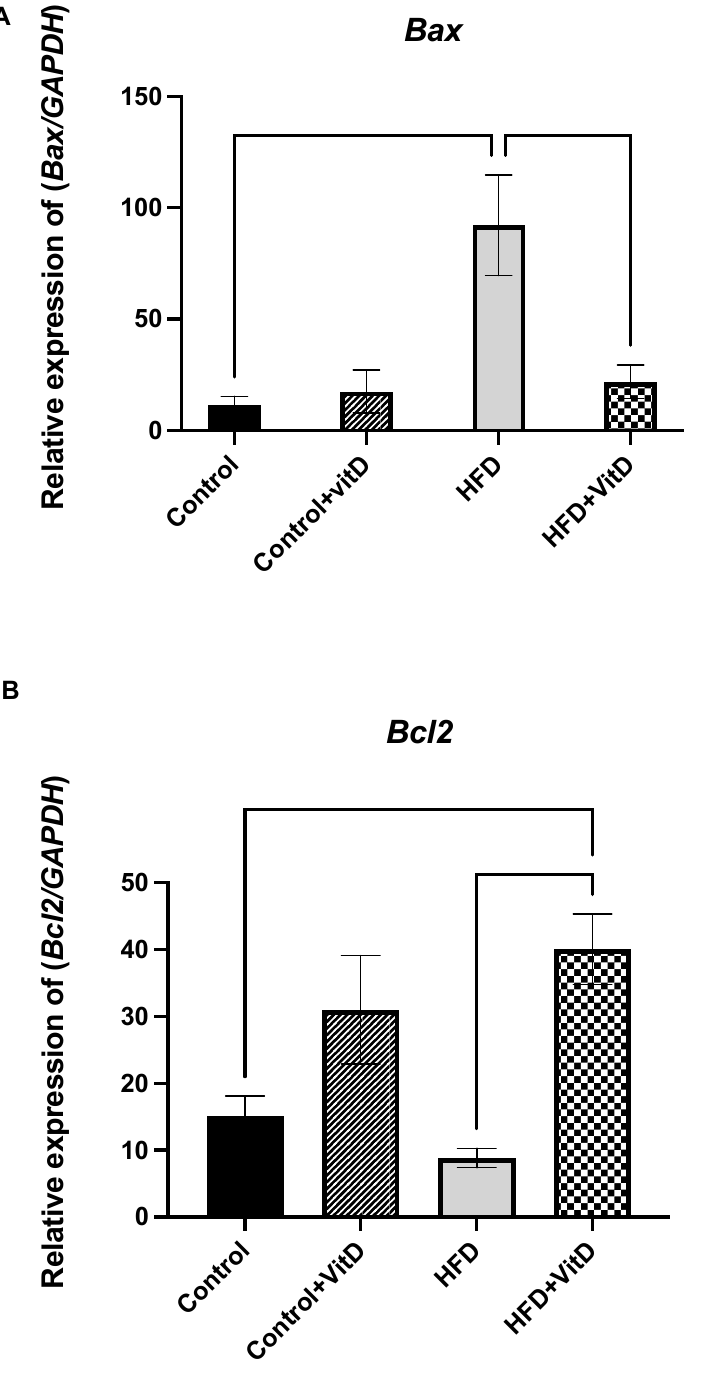
Figure 1. Gene expression of the intrinsic apoptotic signaling genes. ( A ) The gene expression of the pro-apoptotic Bax in rats fed with a normal diet (Control), a high-fat diet (HFD), and a vitamin D-supplemented HFD (HFD + VitD). Bax was significantly increased in the group fed with the HFD ( p = 0.013) relative to the control. Combining vitamin D with the HFD downregulated the expression of this gene ( p = 0.02). ( B ) The gene expression of the anti-apoptotic Bcl2 . Combining VitD with the HFD caused a significant upregulation relative to the control and HFD groups ( p = 0.0056, p ≤ 0.0001). Data were normalized to the reference gene GAPDH. All data were expressed as mean ± SEM. Data were considered significant if p < 0.05.